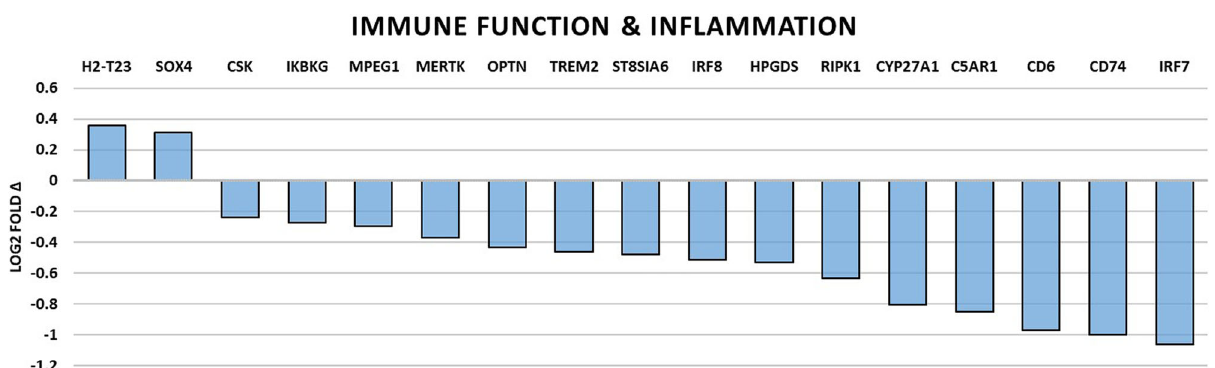
Fig. 3 Space fl ight-induced changes of gene expression related to immune function and in fl ammation. Bar graph summarizing log2 fold- changes of signi fi cantly differentially expressed genes (DEG) ( p < 0.05) in the fl ight (FLT) group compared to the ground control (GC) group in genes directly related to immune function and in fl ammation. N = 6/group. p values are calculated using one-way analysis of variance (ANOVA) and Tukey ’ s HSD (honestly signi fi cant difference) test. Source data are provided as a Source Data fi le.